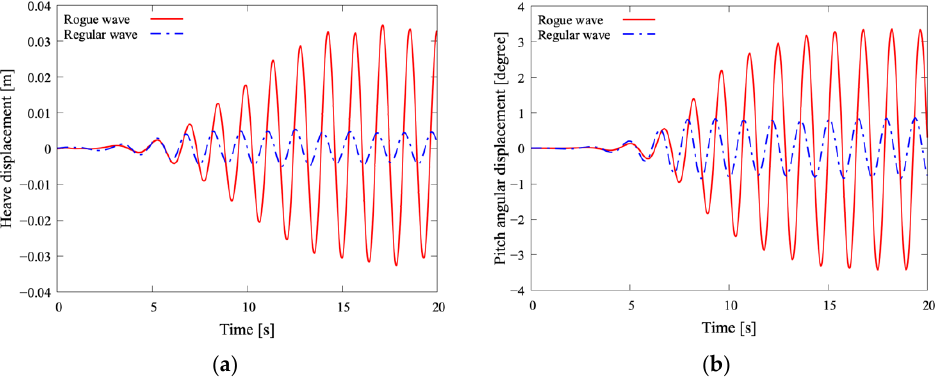
Figure 18. Motions of a floating body: ( a ) heave motion; ( b ) pitch motion.